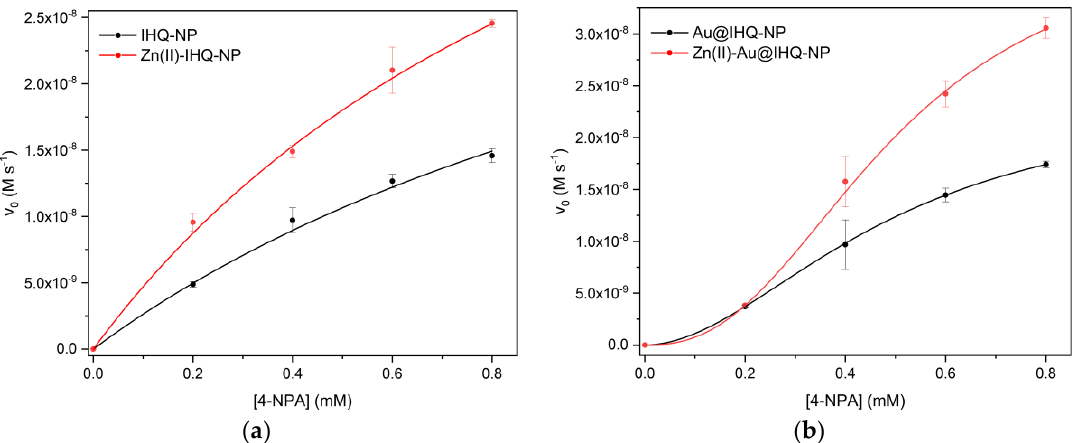
Figure 3. Saturation curves of background-corrected 4-NPA hydrolysis catalyzed by ( a ) IHQ-NP and ( b ) Au@IHQ-NP in absence and presence of Zn(II), respectively. Hydrolysis reactions were carried out in 50 mM Tris/HCl buffer pH 8 with 5% acetonitrile at 25 °C. (Immobilized) IHQ-NP concentration of 10 µM was used, while 100 µM ZnCl 2 was added for reactions in presence of Zn(II).